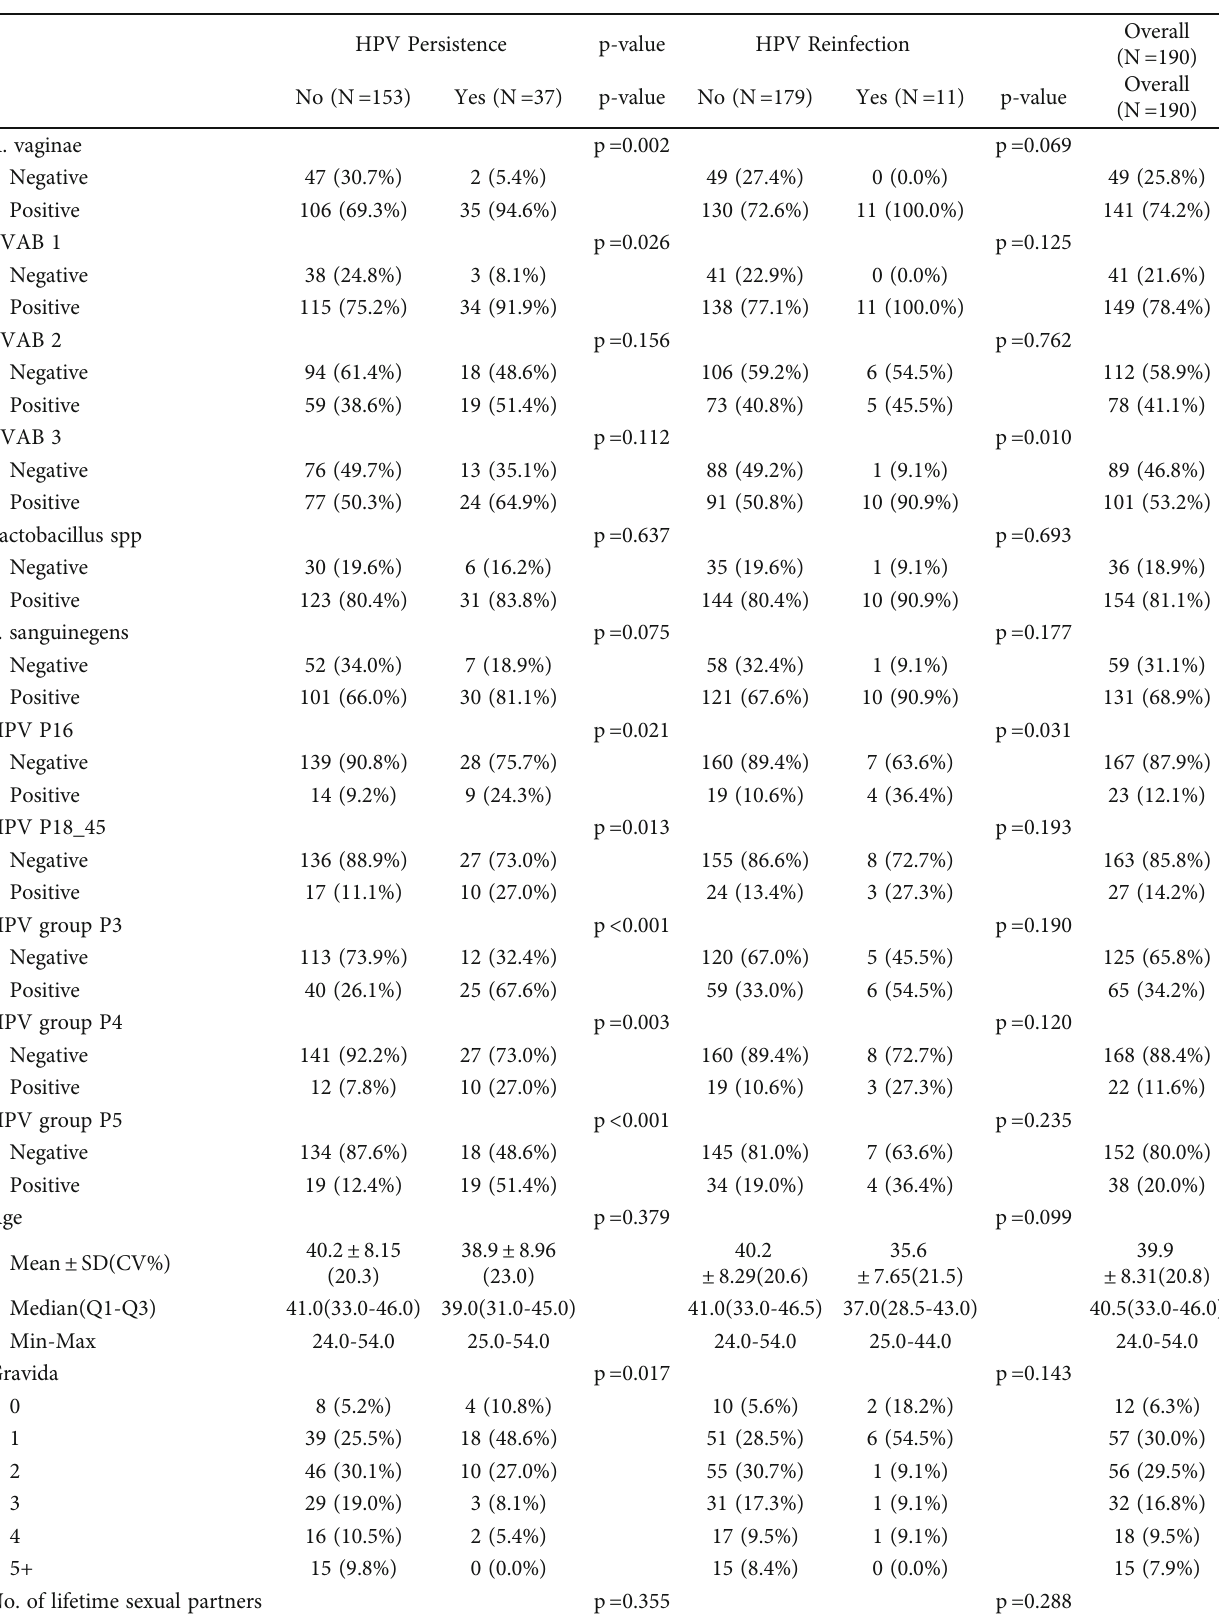
Table 4: Factors associated with HPV persistence and reinfection in HIV positive